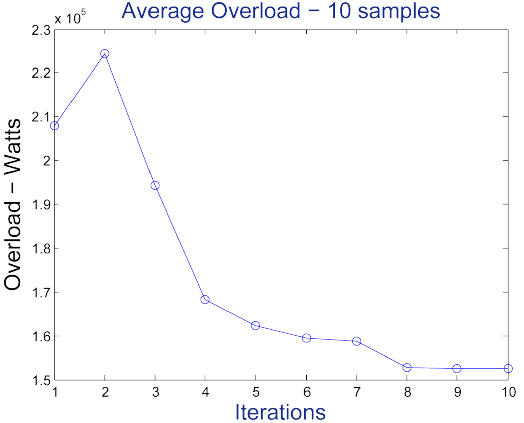
Figure 2. The peak (upper plot) and mean (lower plot) power load (Watts) of a 5 agents neighborhood is displayed at the first of the distributed algorithm proposed in Section 2. The red (black) curve represents the district global load we aim to attain. It has to be compared with the result at the last iteration displayed in Fig. 3. All agents are flexible during 10 am-9 pm.